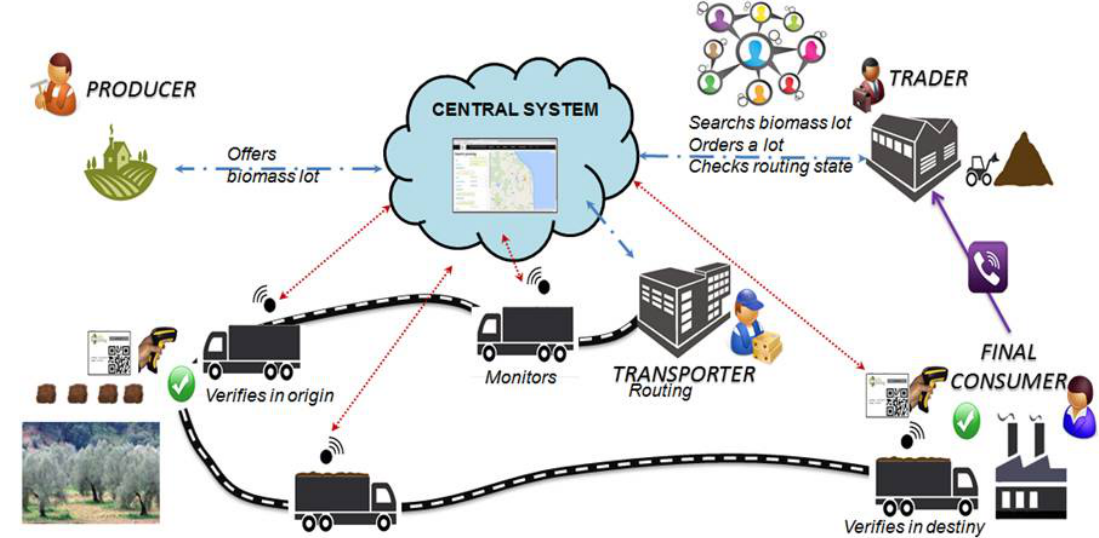
Figure 3. Linkage between different activities of actors along biomass supply chain with application of SLS. Source: Created by authors using free Icons obtained from FREEPIK [18].